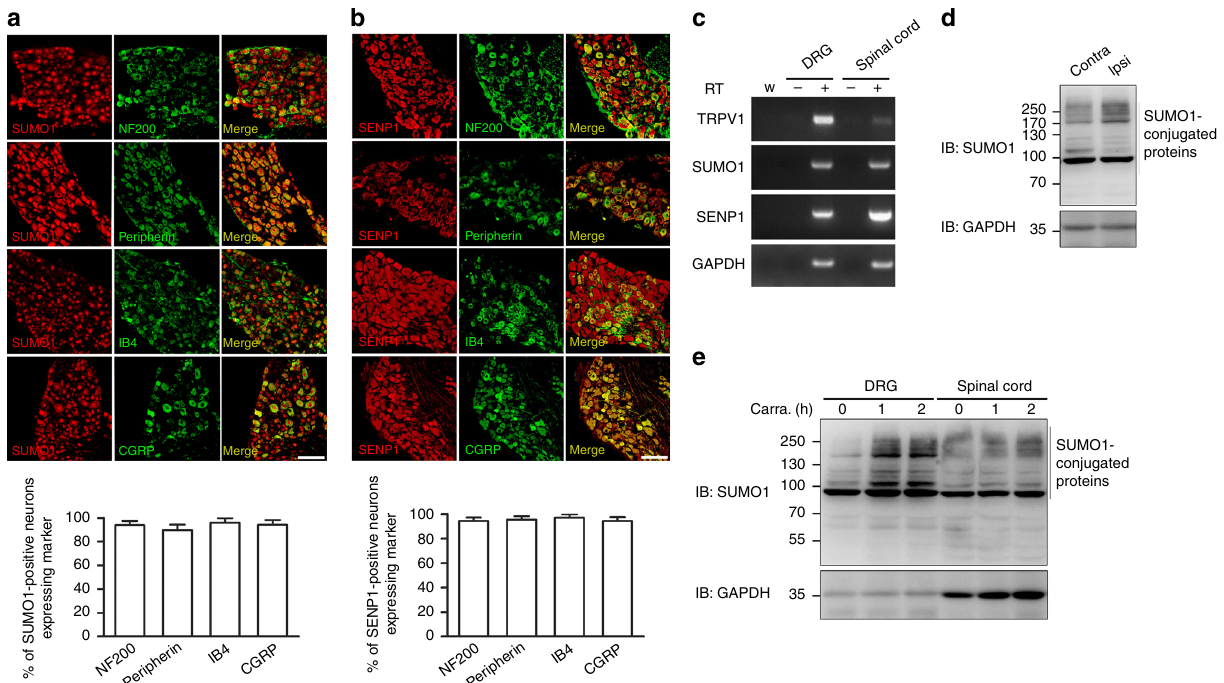
Fig. 1 Expression of SUMO1 and SENP1 in DRG neurons. a Distribution of SUMO1 in DRG neurons. DRG neurons were permeabilized and double labeled with SUMO1 (red) and NF200, peripherin, IB4 and CGRP (green). The percents of SUMO1-positive neurons among those labeled with the indicated markers are shown in the bar graph below. The total numbers of neurons analyzed ( n ) ranged from 48 to 89 cells per condition. Data are means ± s.e.m, from three experiments. Scale bar: 100 μ m. b Distribution of SENP1 in DRG neurons. Similar to a but SENP1 was used in place of SUMO1. The total numbers of neurons analyzed ( n ) ranged from 64 to 117 cells per condition. Data are means ± s.e.m, from three experiments. Scale bar: 100 μ m. c RNA analysis by RT-PCR of TRPV1, SUMO1, SENP1, and GAPDH levels in DRG and spinal cord from adult wild-type mice. Negative controls: samples without reverse transcriptase ( − RT) and water (W). Gel images are representatives of three independent experiments. d SUMO1-conjugated proteins were increased in DRG in the ipsilateral side of carrageenan-injected hindpaw as compared to the contralateral side. Carrageenan (2%, 20 μ l) was administered by intraplantar injection into the left hindpaw of wild-type mice. L3 – L4 DRG at the left (Ipsi) and right (Contra) sides were dissected 1 h after the injection and SUMO1-conjugated proteins were measured by western blotting. GAPDH was used as the loading control. Blots are representatives of three independent experiments. e SUMO1-conjugated proteins were increased in DRG but not spinal cord. At 0, 1, or 2 h after intraplantar injection of carrageenan (Carra.) into both hindpaws, L3 – L4 DRG from both sides and spinal cord were dissected for western blotting for SUMO1 and GAPDH. Blots are